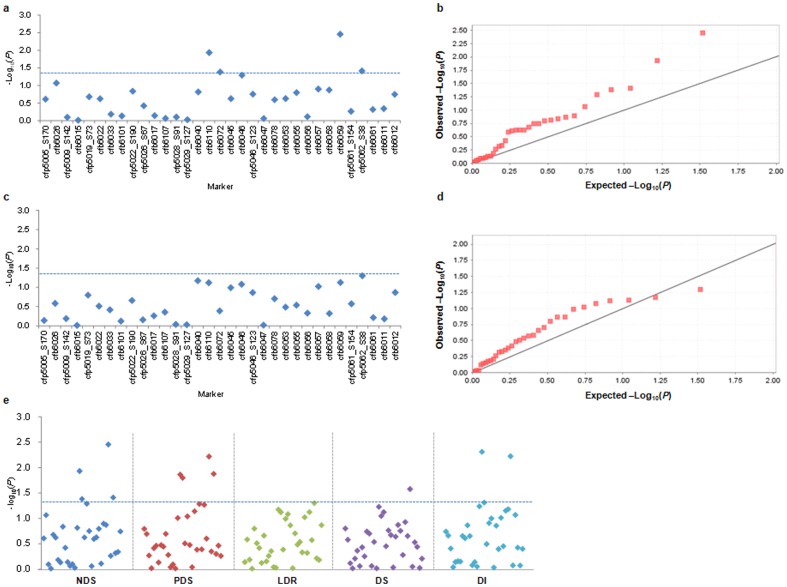
Associations of five FHB-related traits with molecular markers in the 3.1 -Mb genomic region.(a) Dot plots of the compressed mixed linear model (MLM) for numbers of diseased spikelets (NDS). Negative log10-transformed P values in a sequenced contig (ctg954) of 3.1-Mb are plotted against position along the chromosome region. Blue horizontal dashed line represents the chromosome-region significance threshold. (b) Quantile-quantile plot of compressed MLM for NDS. (c) Dot plots of compressed MLM for lengths of diseased rachides (LDR), as in a. (d) Quantile-quantile plot of compressed MLM for LDR. (e) Dot plots of compressed MLM for five FHB phenotypic traits, i.e. number of diseased spikelets (NDS), percentage of diseased spikelets (PDS), the length of diseased rachides (LDR), disease severity (DS) and disease index (DI), as in a.